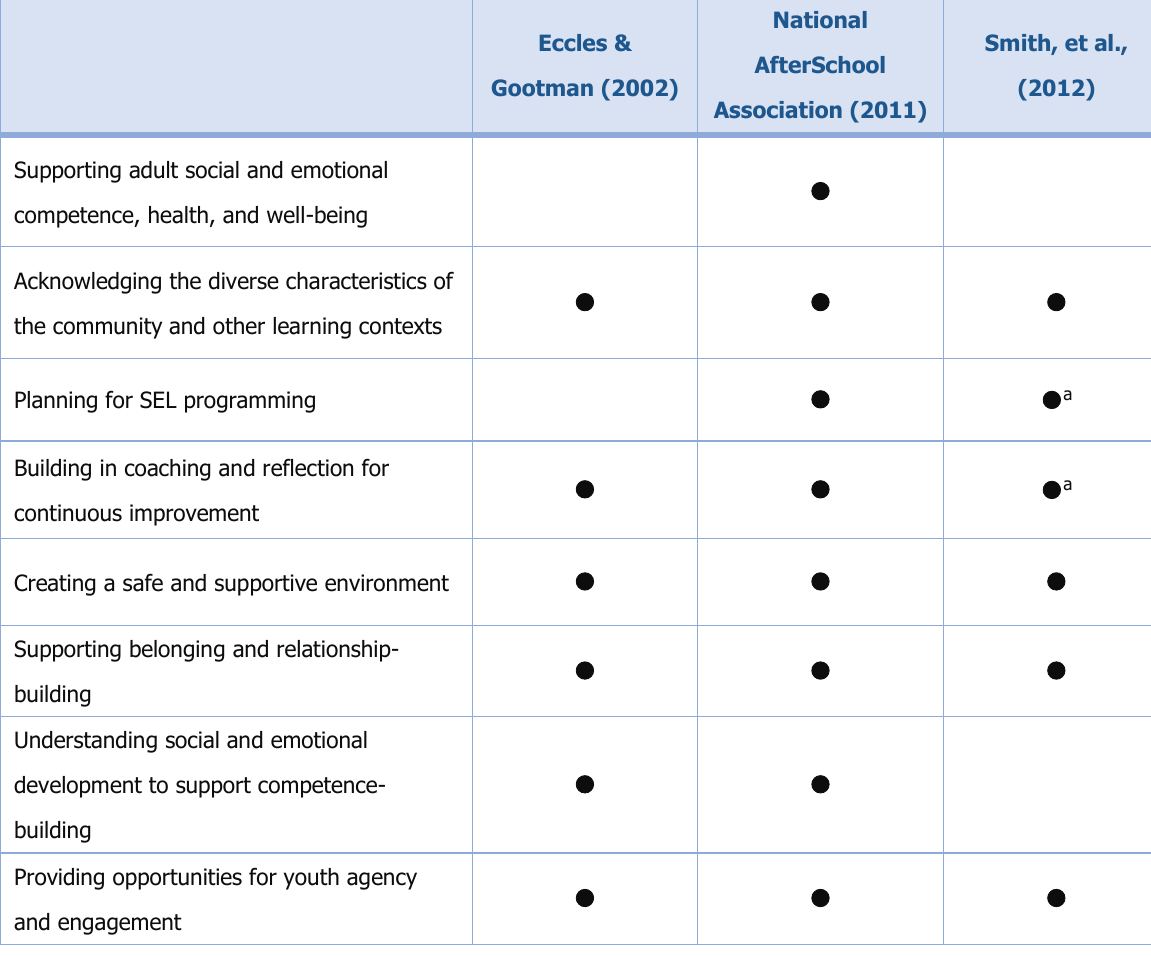
Table 3. Crosswalk of SEL Practices With Seminal Youth Development